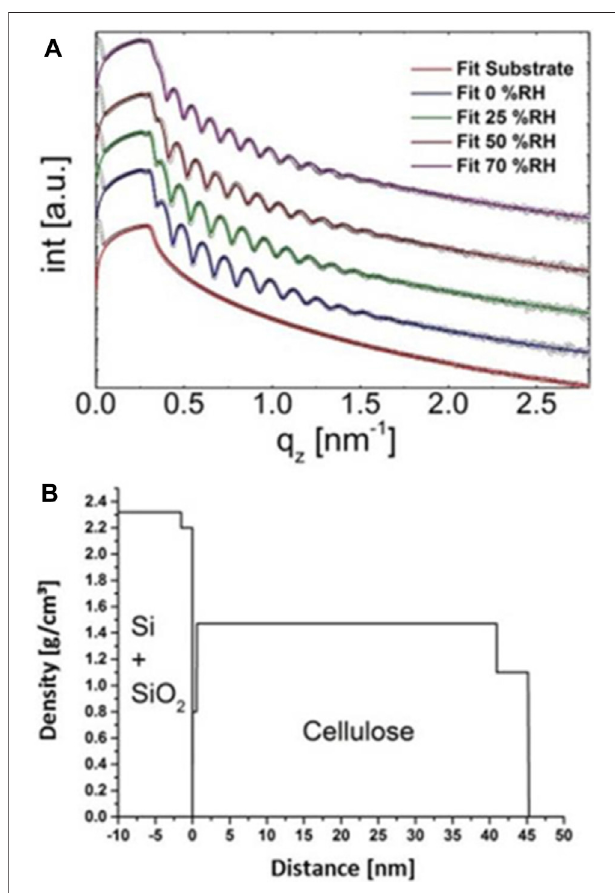
FIGURE 2 | (A) XRR curves of a cellulose thin fi lm on a silicon water at different humidities and (B) the resulting density pro fi les at 0% relative humidity. Reproduced with permission (CC BY) from Sampl et al.